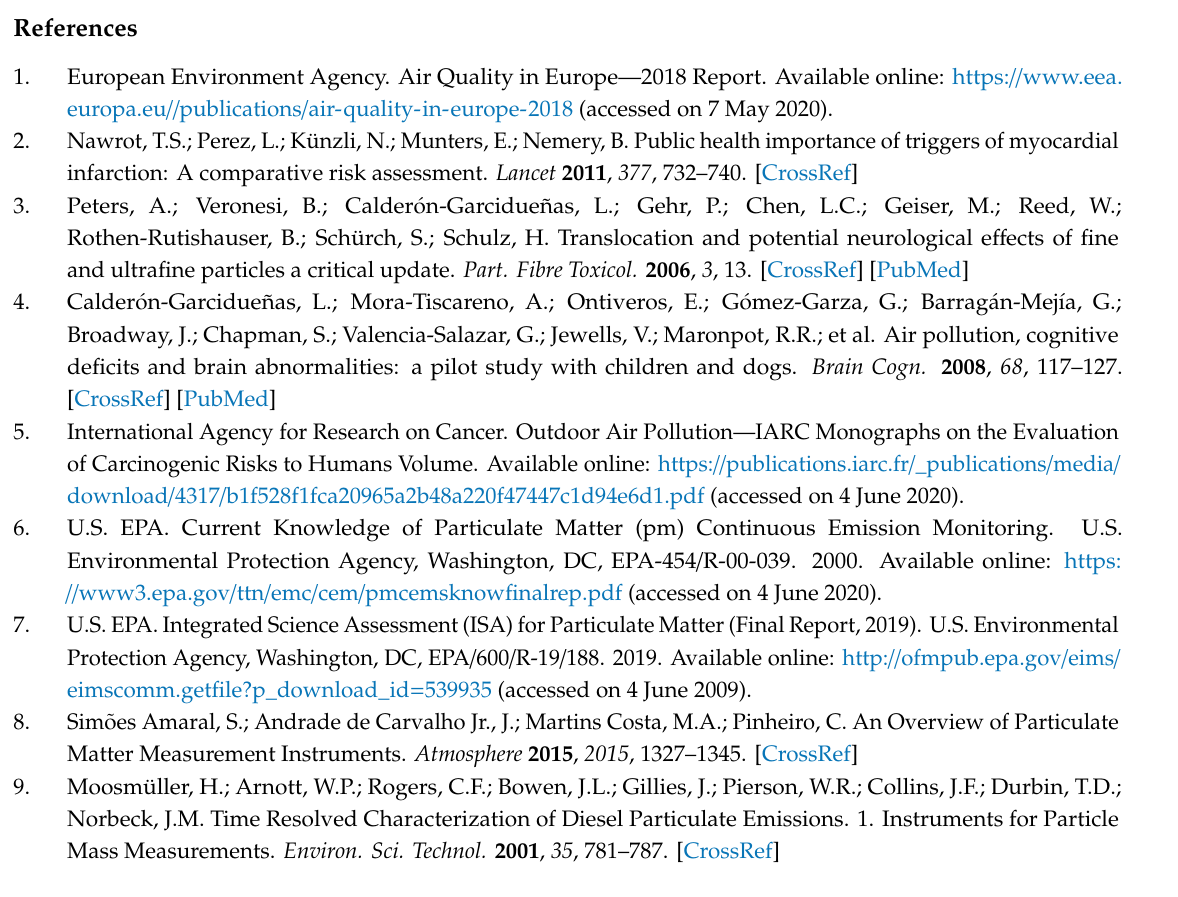
Figure S1: Parametric study of the formulation regarding the dielectric constant of the pure